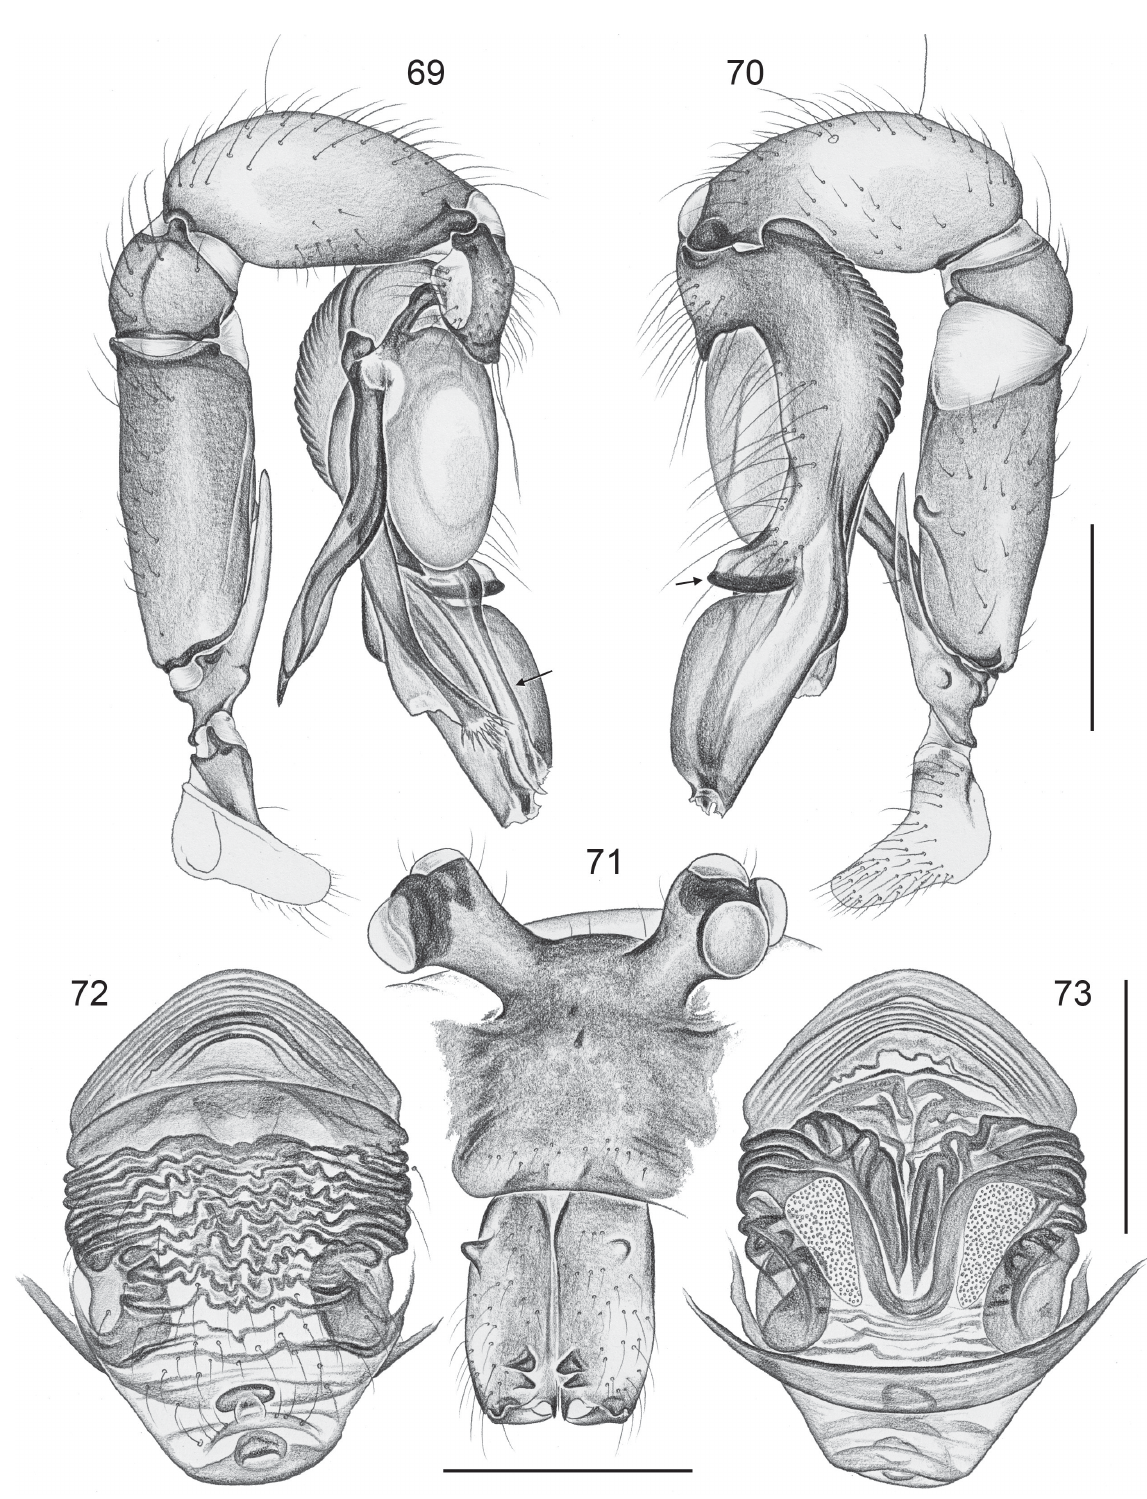
Figs 69–73. Panjange kubah Huber, sp. nov. (ZFMK Ar 14587–88). 69–70 . Left male palp, prolateral and retrolateral views (arrows point at distinctive processes). 71 . Male ocular area, clypeus, and chelicerae, oblique frontal view. 72–73 . Cleared female genitalia, ventral and dorsal views. Scale lines: 0.5